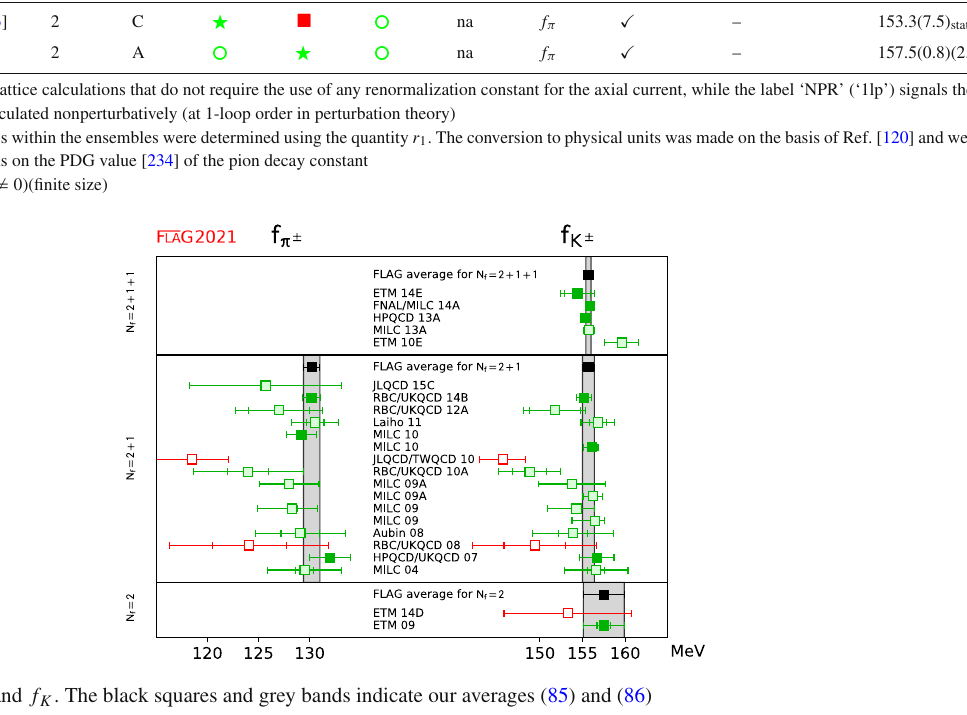
Collaboration Refs.